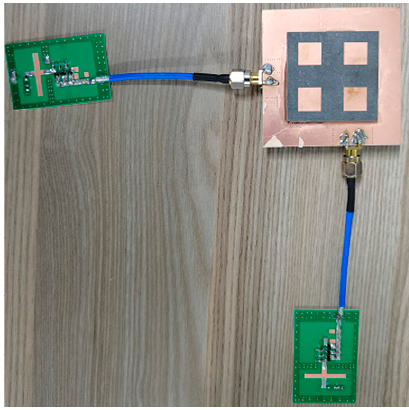
Figure 16. Fabricated rectifying circuit.